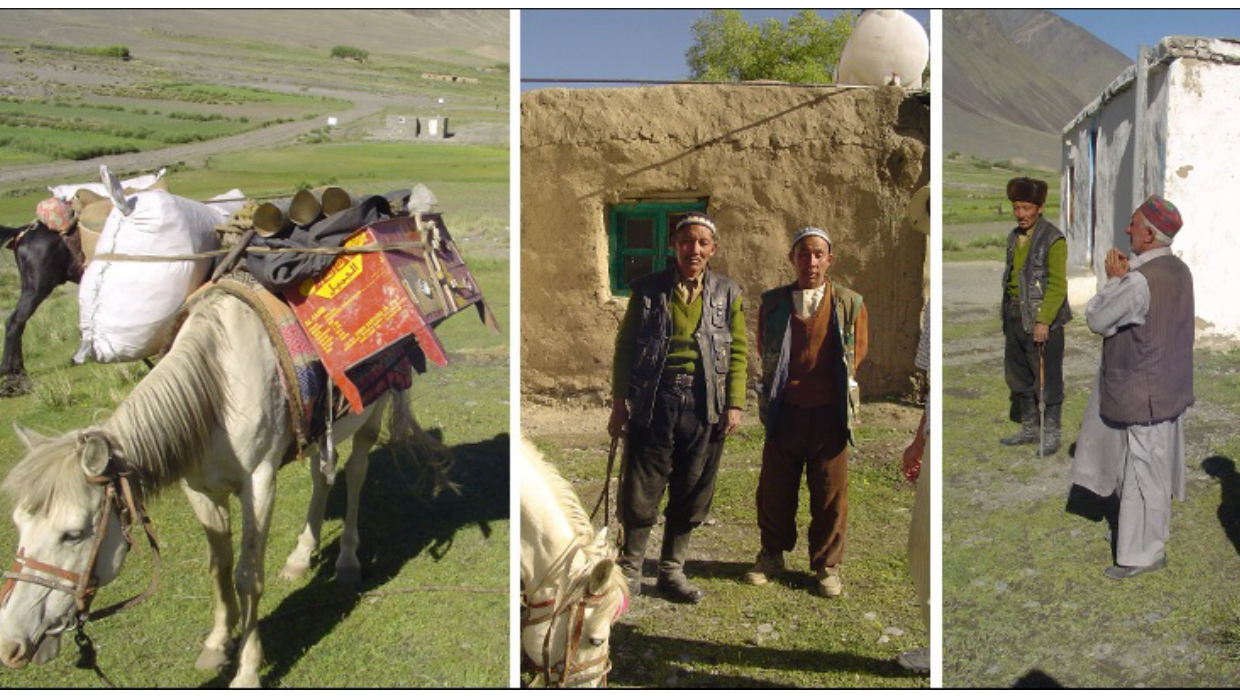
Fig. 4 . After completing trading transactions: Kyrgyz guests at the home of Chaqanboy in the Wakhi village of